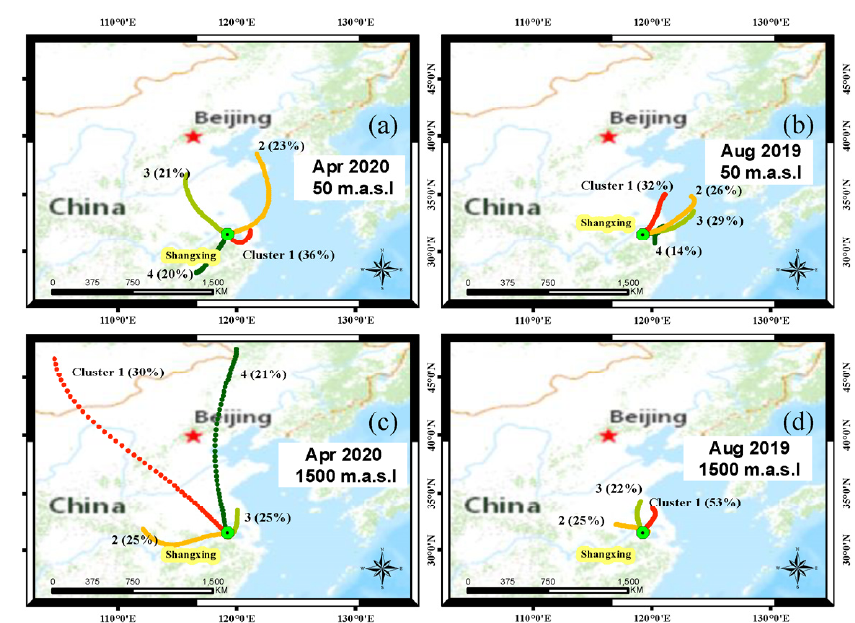
Figure 8 Figure 8. Clustering analysis of backward trajectories of episode 1 ( a , c ) and episode 2 ( b , d ). The first and second rows represent trajectories arriving at the Nanjing site at the levels of 50 and 1500 m above sea level, respectively. The number beside each trajectory cluster denotes the contribution of the air mass alongside the corresponding trajectory. The red, orange and green lines in each figure denote different contribution levels with red line representing the highest, green the lowest, and orange and olive green the intermediate. The base map is supported by